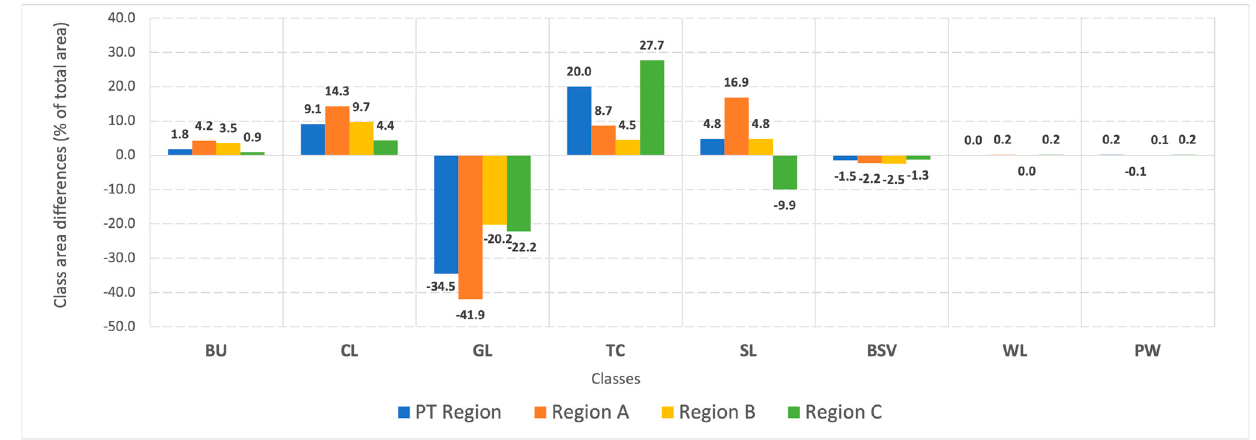
Figure 6. Differences of class area percentages between COS18 and WC20 (COS18 area% − WC20 area% ) for all the study sites.